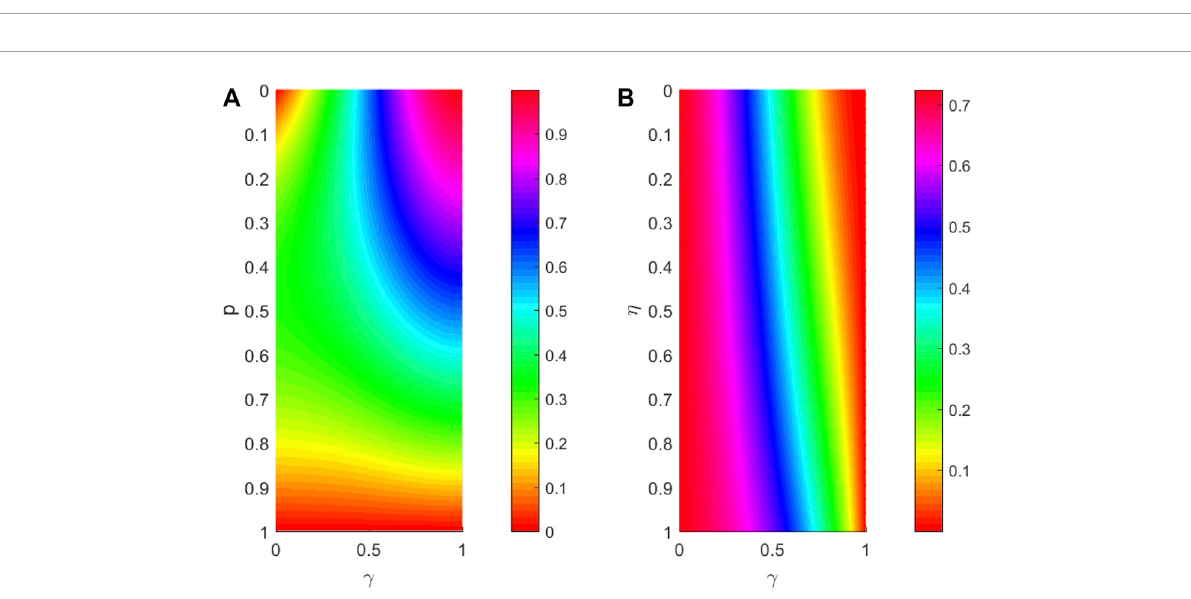
FIGURE 8 (color online) (A) F av imp as a function of γ and p with μ = 1 and η = 0.8. (B) F av imp as a function of γ and η with μ = 1 and p = 0.8. The polarization parameter θ is π